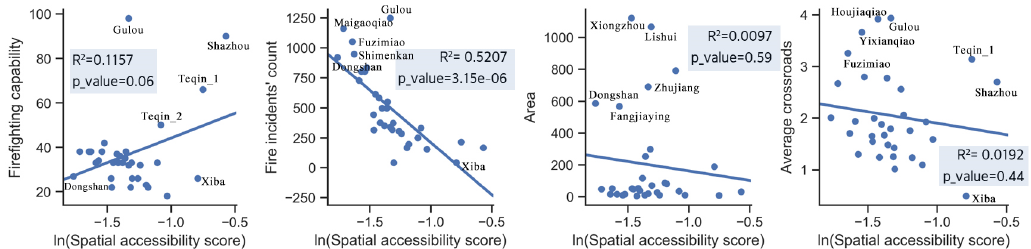
Figure 10. The correlation between the spatial accessibility score (logarithm) and the firefighting capability, the fire incidents’ count, the area, the average crossroads.